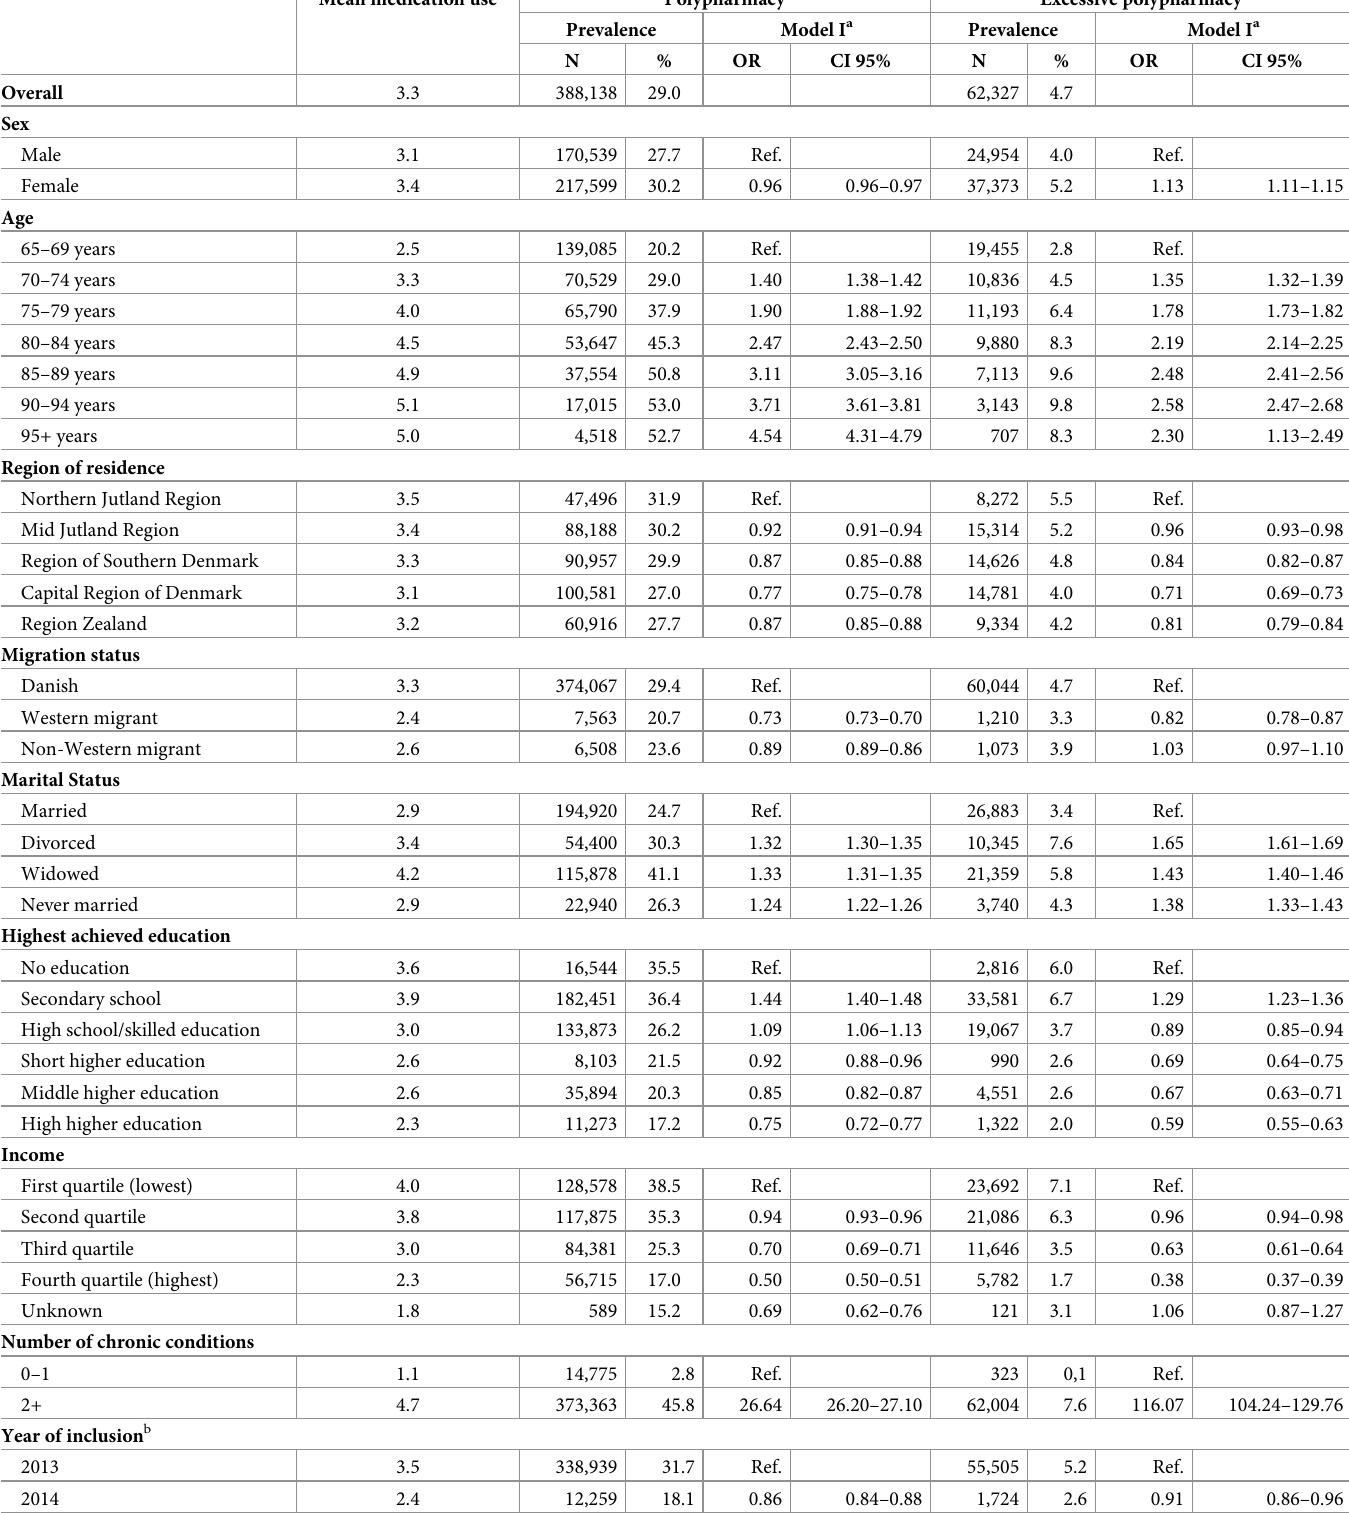
Table 2. Prevalence and risk of being exposed to polypharmacy and excessive polypharmacy at the time of inclusion (N =